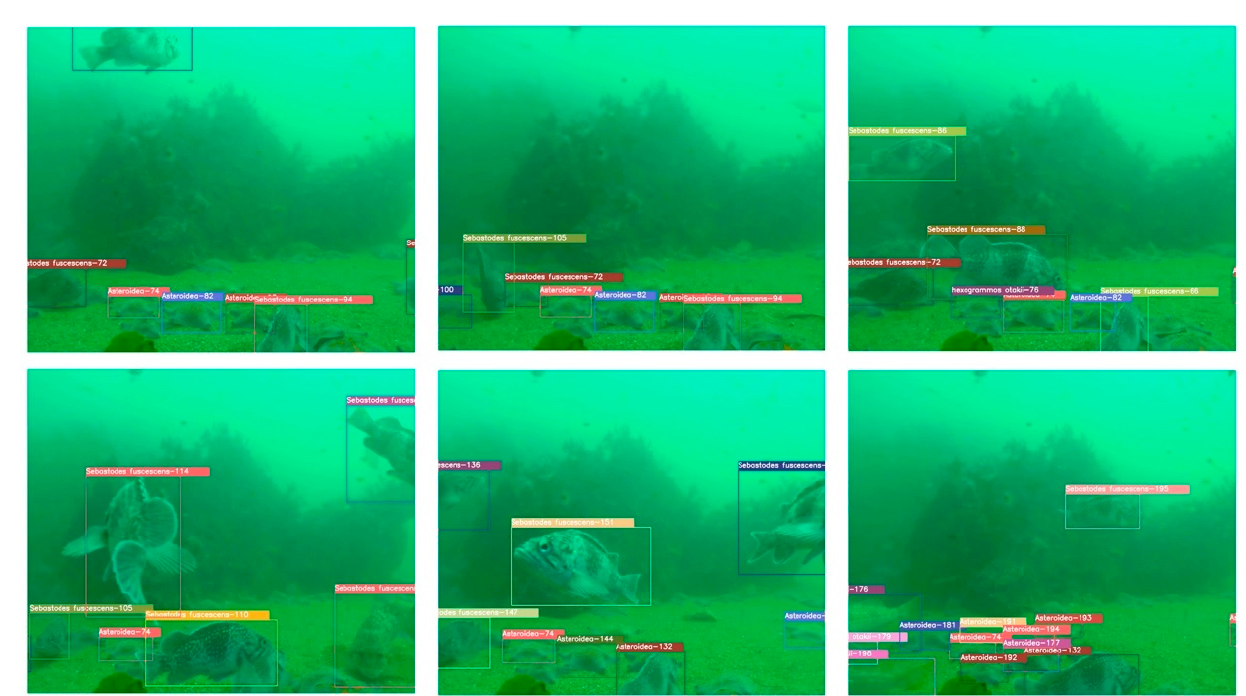
Figure 5. Visualization result of the FSTA. We selected six sequences from the validation set of our dataset and showed the effectiveness of FSTA to handle complex cases such as occlusion and motion blur.